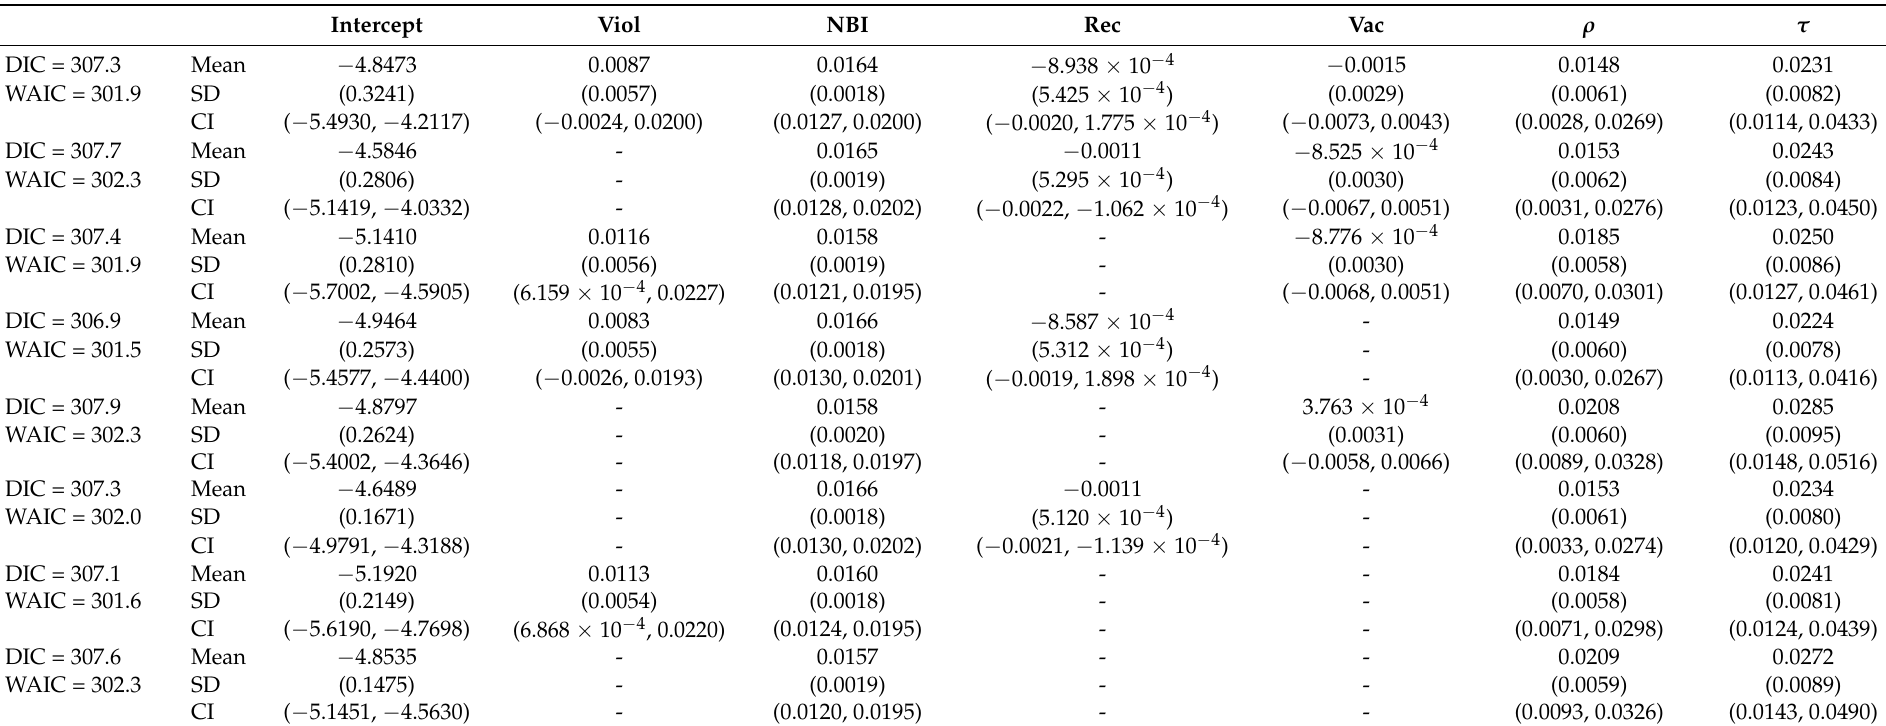
Table 8. Parameter estimates, standard deviations and 95% credible intervals for the estimated means in parenthesis, DIC and WAIC values for the reduced versions of the spatial conditional normal Poisson model fitted in INLA to the Colombian infant mortality rates data